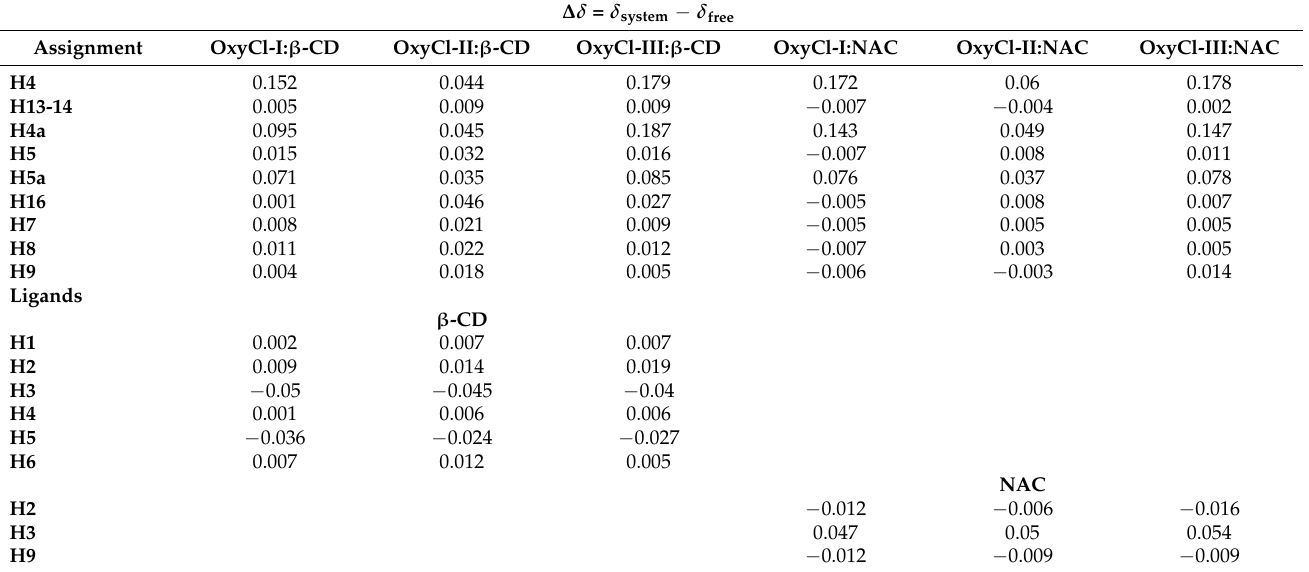
Table 7. 1 H NMR chemical changes ( ∆ δ ) in the binary